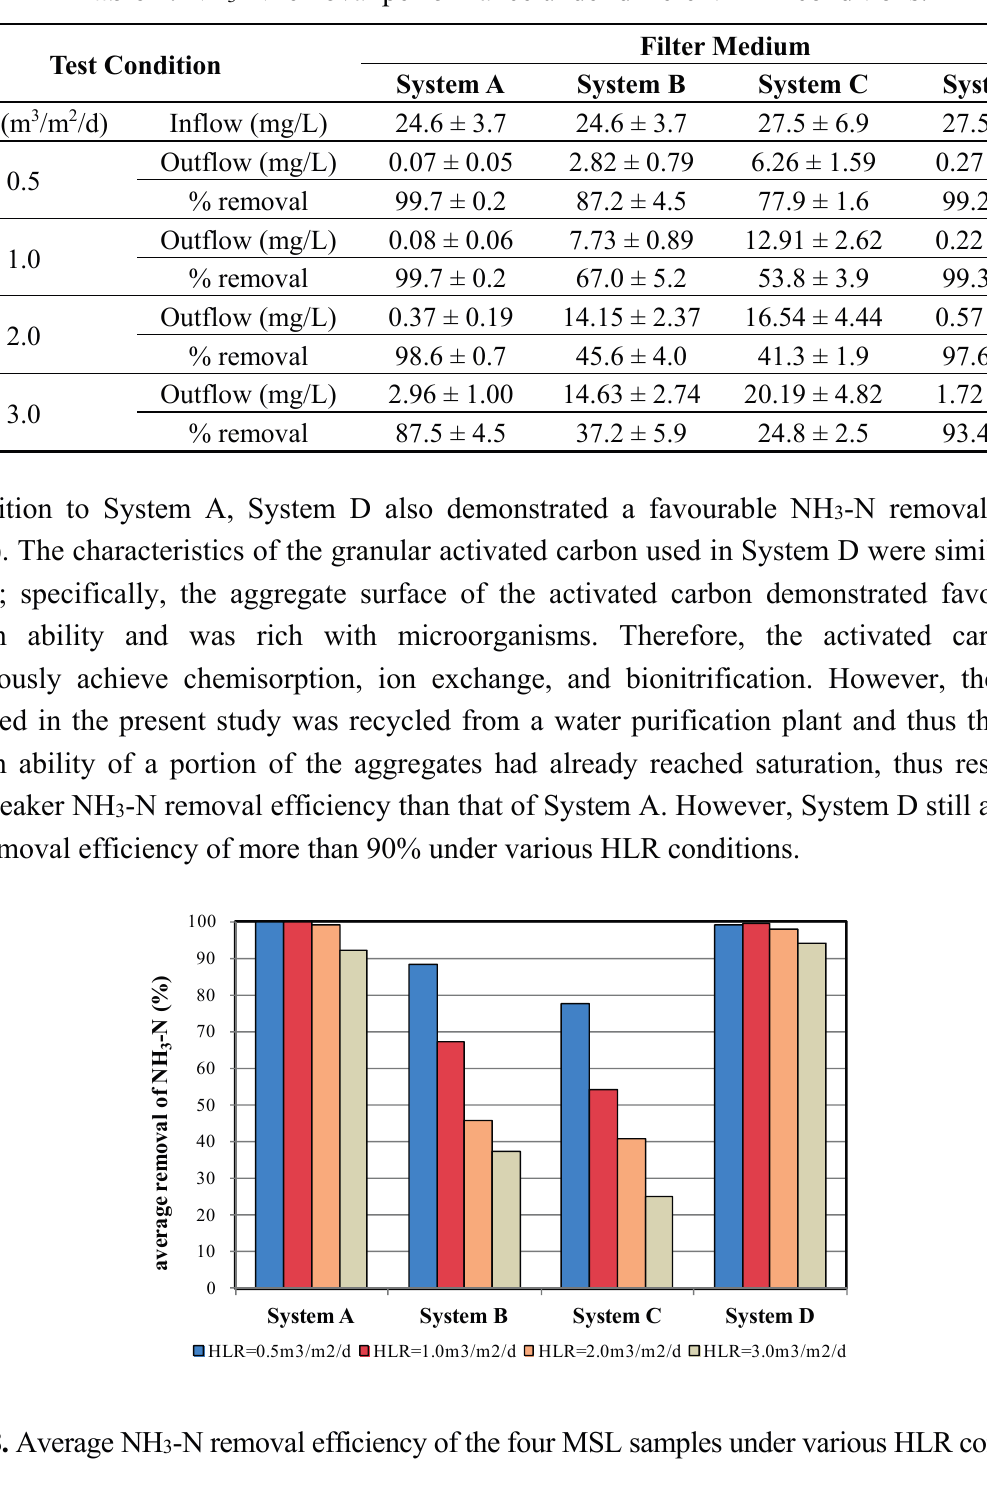
Table 4. NH 3 -N removal performance under different HLR conditions.